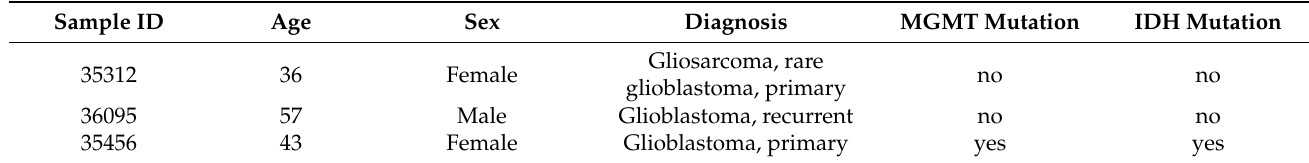
Table 3. Tumor/patient demographic